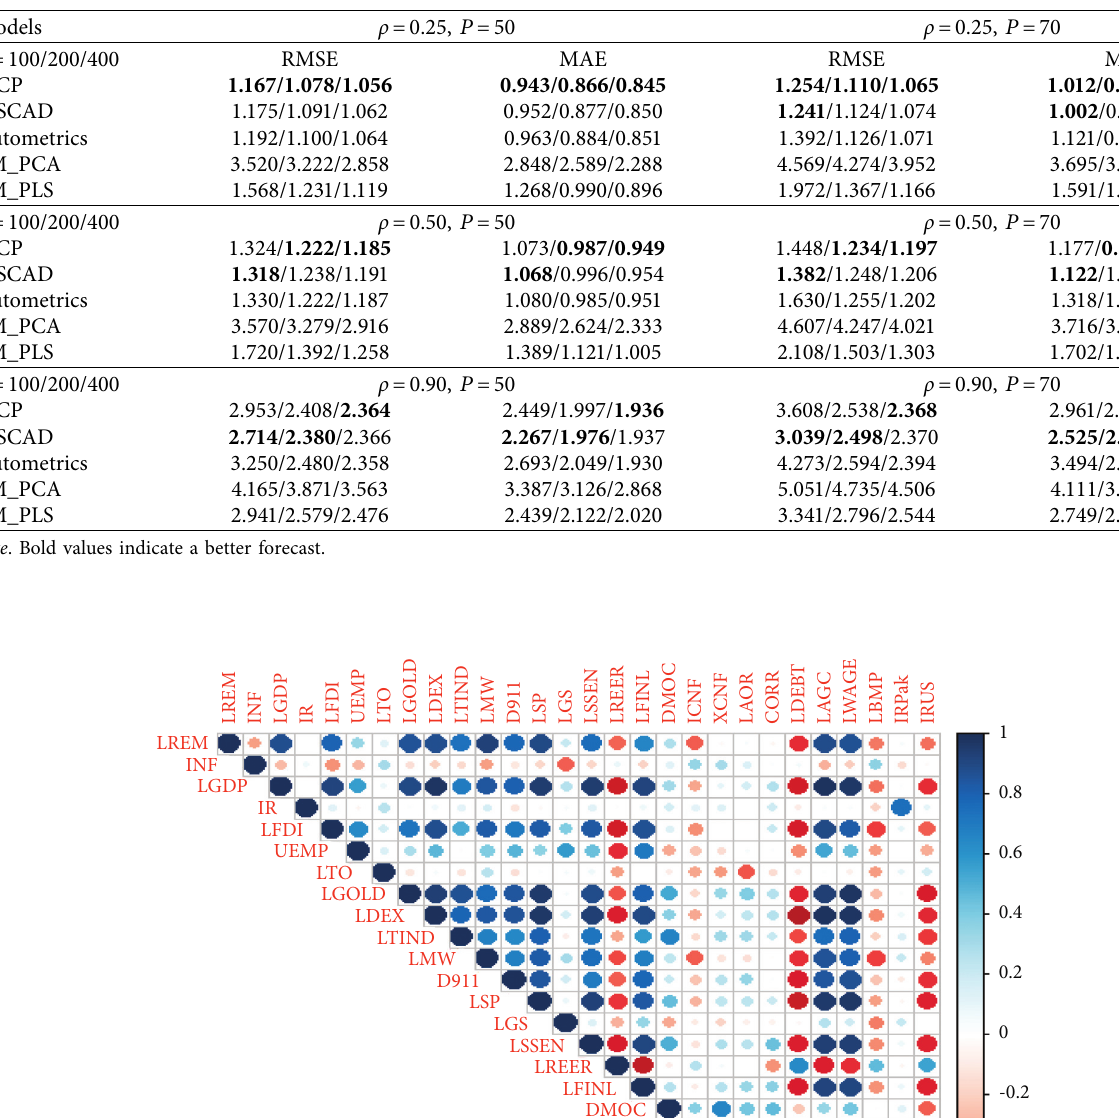
Table 3: Forecast comparison under autocorrelation from Monte Carlo simulation (Scenario 3).